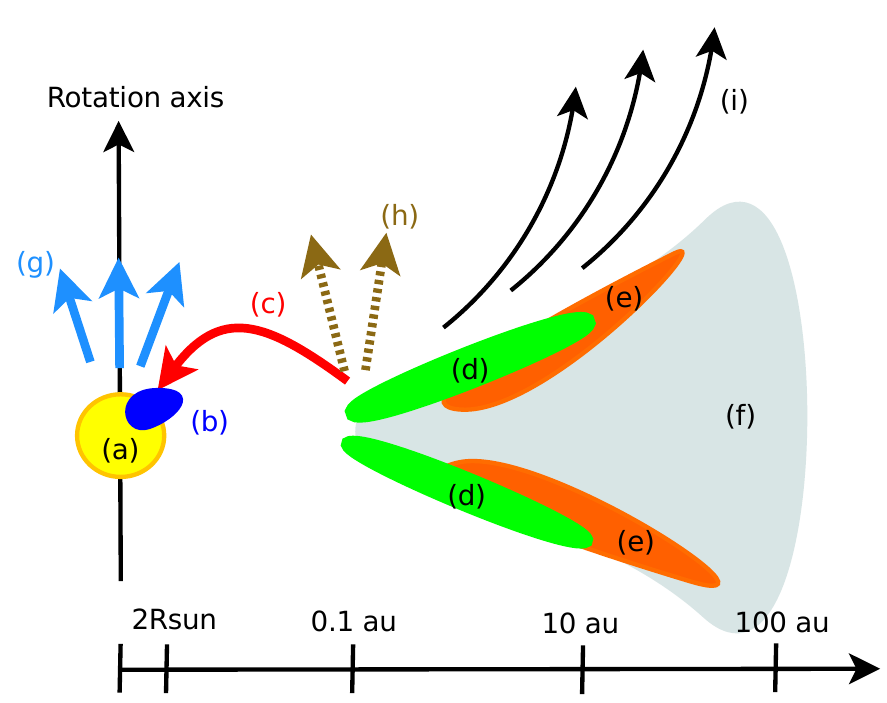
Figure 2. Sketch of a CTTS system with regions that are relevant for FUV studies labeled. Relative positions are correct, but relative distances and sizes are not. The relevant components are ( a ) the pre-main-sequence star, ( b ) the accretion shock on the stellar surface, ( c ) the accretion funnel, ( d ) the inner, hot disk region ( T ∼ 2,000K), ( e ) cooler regions of the inner disk surface ( T ∼ 500K), ( f ) cool protoplanetary disk material, ( g ) a spherical (stellar) wind, which may be seen in emission or as an absorption component in strong emission lines (e.g., C IV ), ( h ) an X-wind, and ( i ) a disk wind. https://www.overleaf.com/project/